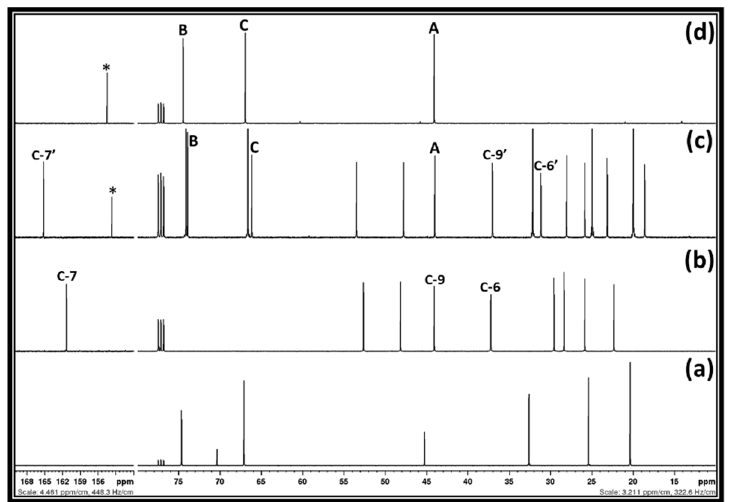
Figure 4 . 13 C NMR spectra of the ( a ) 1,3-dichloro-2-propanol in 2-Me-THF, ( b ) DBU and, ( c ) Reaction mixture after equivalent interaction of 1,3-dichloro-2-propanol, DBU, and CO 2 in 2-Me-THF, and ( d ) 3-chloro-1,2-propylenecarbonate (NMR analysis in CDCl 3 ). Therefore, similar to DMSO, 2-Me-THF can be used as a solvent in the synthesis of 3- chloro-1,2-propylenecarbonate. In this case, 2-Me-THF is preferred more considering its renewable nature and this solvent is already referred to as an alternative to THF and other organic solvents [27,28]. After the completion of the reaction, 2-Me-THF was further re- moved by evaporation and [DBUH][Cl] salt was separated from 3-chloro-1,2-propylene- carbonate using ethyl acetate solvent and a filtration technique. Further, 93% of the 3- chloro-1,2-propylenecarbonate was recovered when ethyl acetate was removed from the organic phase. Hence, the use of 2-Me-THF in the synthesis not only facilitated the sepa- ration of components from the reaction mixture but also further allowed a higher level of recovery of 3-chloro-1,2-propylenecarbonate. To valorize 3-chloro-1,2-propylenecarbonate, it was further explored in the base-cat- alyzed transesterification in methanol where DBU was used as a base and the synthesis was carried out at different temperatures. The current catalytic approaches for the synthe- sis of 3-chloro-1,2-propylenecarbonate from ECH are considered as only an ideal example to demonstrate the valorization of CO 2 upon the synthesis of cyclic carbonates. Hence, 3- chloro-1,2-propylenecarbonate remains underutilized and needs to be upgraded to value- added chemical entities considering the value of the active form of CO 2 in the molecule. The concept of the transesterification of 3-chloro-1,2-propylenecarbonate under alkaline conditions was designed based on the previous reports where the cyclic carbonates such as ethylene carbonates, catechol carbonate, etc. were used to synthesize various aliphatic carbonates [13,29]. As shown in Scheme 4, the reaction of the alkaline transesterification involved the interaction of methanol with 3-chloro-1,2-propylenecarbonate and results in the formation of the DMC and 3-Chloro-1, 2-propanediol. Scheme 4 . Base catalyzed transesterification of the 3-chloro-1,2-propylenecarbonate to DMC and 3- Chloro-1, 2-propanediol.